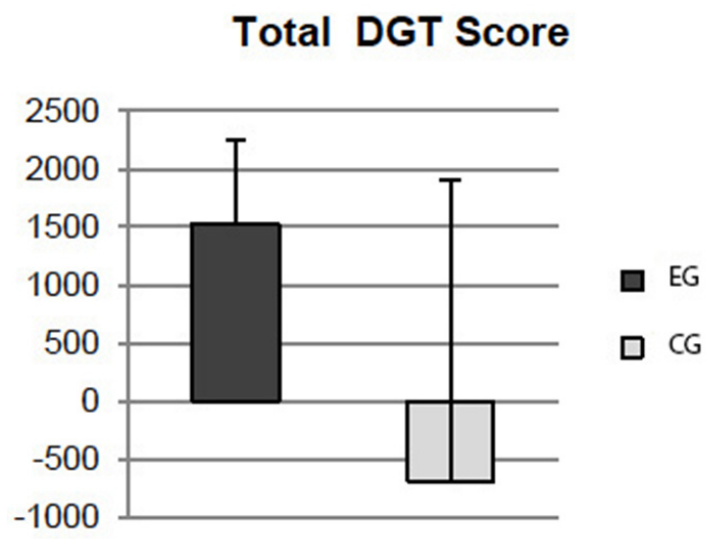
Figure 2. Results at the Game of Dice Task (GDT): effects on Total Score.